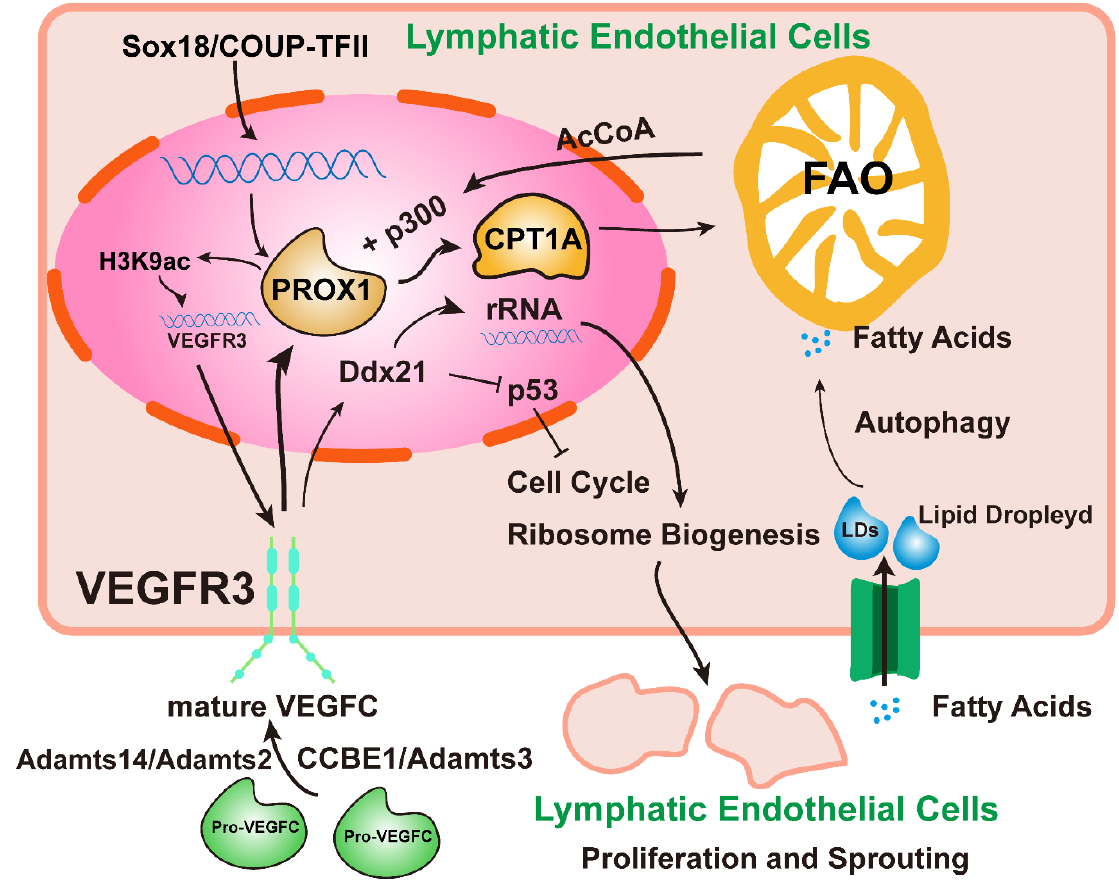
Figure 2. Relationship between VEGFC- and PROX1-related signaling pathways and lipid metabolism. SOX18 and COUP-TFII promote PROX1 transcription and the differentiation of embryonic venous endothelial cells into LECs. Fatty acids enter LECs and aggregate into lipid droplets that are then transported to mitochondria by autophagy to provide the free fatty acids required for FAO. AcCoA is produced by fatty acid oxidation, and acetyltransferase p300 acetylates histone H3K9ac of PROX1 to promote VEGFR3 expression. Prox1 promotes CpT1A-dependent fatty acid β -oxidation to further increase AcCoA production. In addition to interacting with PROX1, VEGFC/VEGFR3 signaling can also regulate the expression of ribosomal RNA through Ddx21 and inhibit the positive regulation of the cell cycle by p53, thus promoting the proliferation of LECs. Endogenous pro-VEGFC must be cleaved by CCBE1/Adamts3 and Adamts14/Adamts2 to become mature VEGFC, which can bind to VEGFR3 and regulate PROX1 expression.